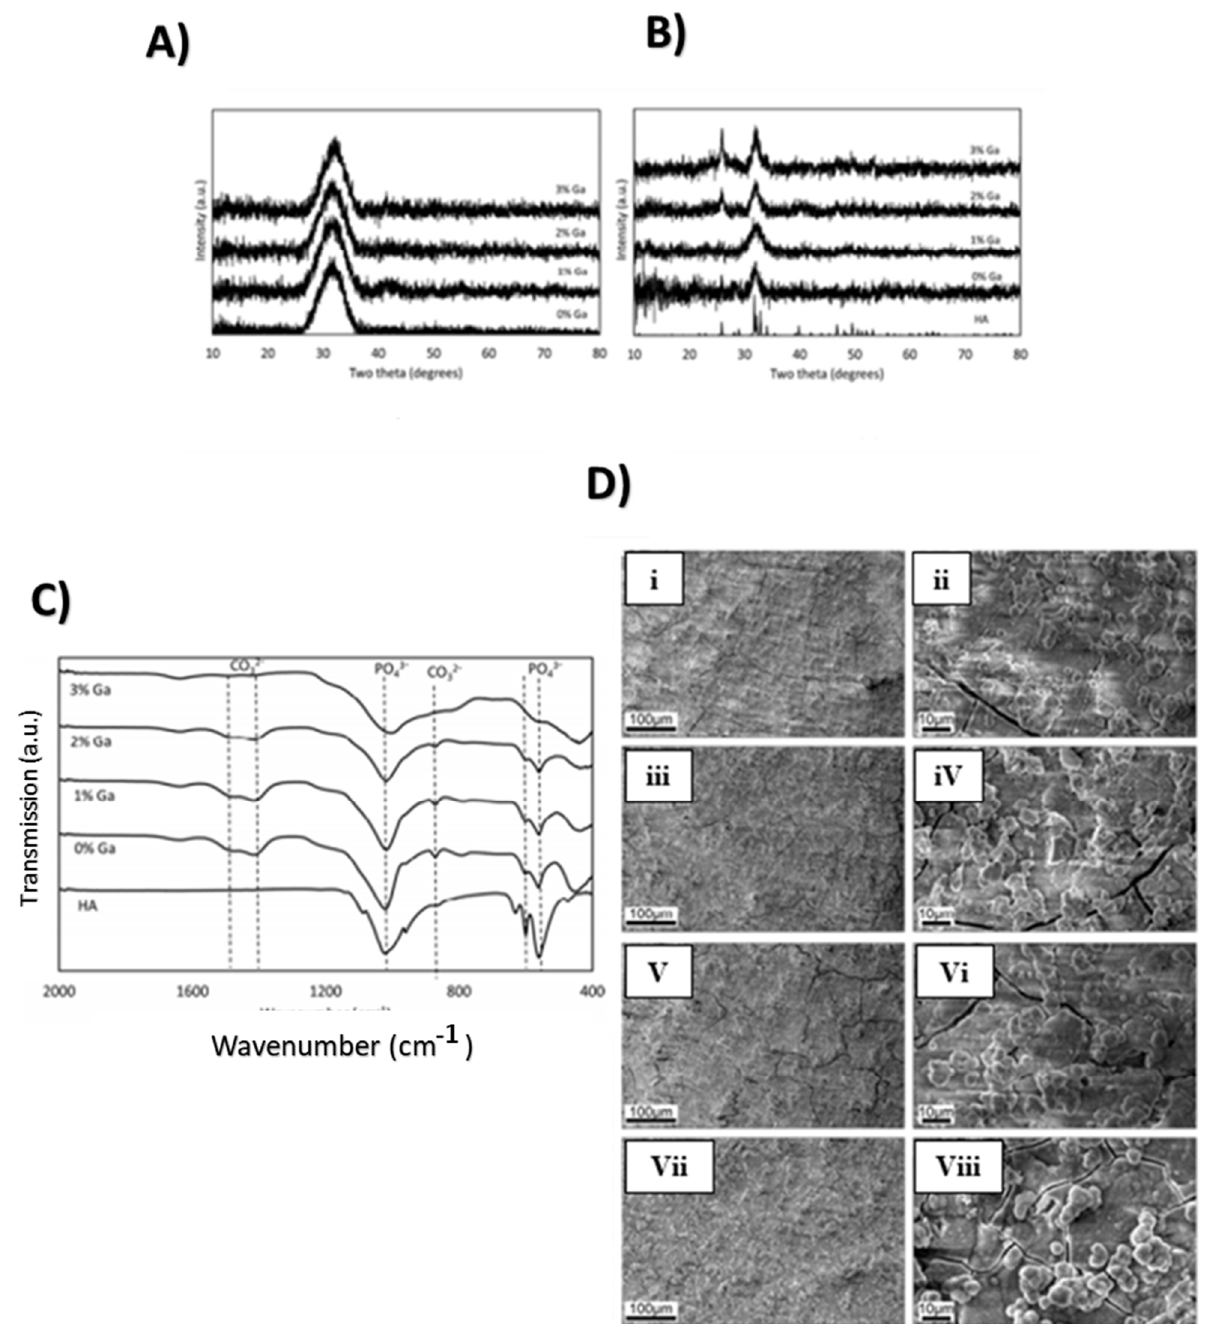
Figure 2. ( A ) XRD spectrum for unreacted BG; ( B ) XRD spectrum for BG after 7 days in SBF, with hydroxyapatite shown as a reference; ( C ) FTIR spectra of Ga doped BG following immersion for 7 days in SBF; ( D ) SEM image of BG after 7 days in SBF. (Adapted from [3]).